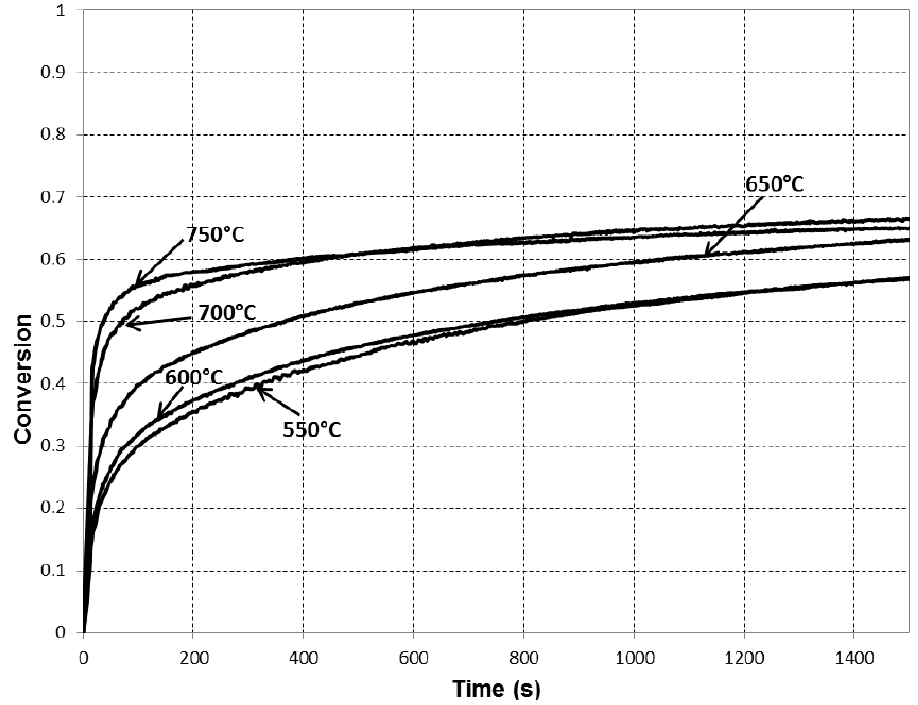
Figure 4. Carbonation behavior of the sample